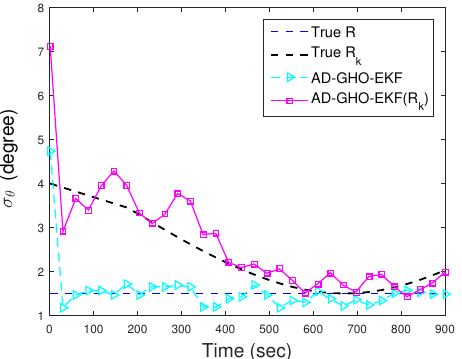
Figure 4. True and estimated R (both time-varying and time-invariant) for Scenario